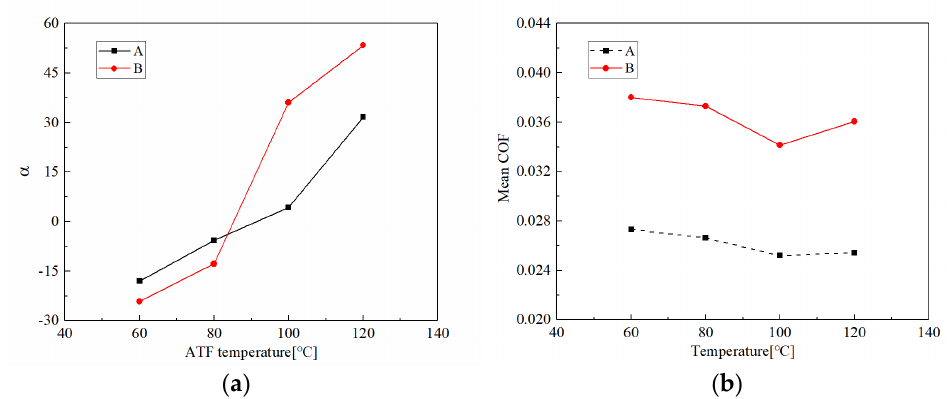
Figure 7. The variable coefficients in stable working stage ( a ), and friction torques of CBFM-A and CBFM-B in different ATF temperatures ( b ).